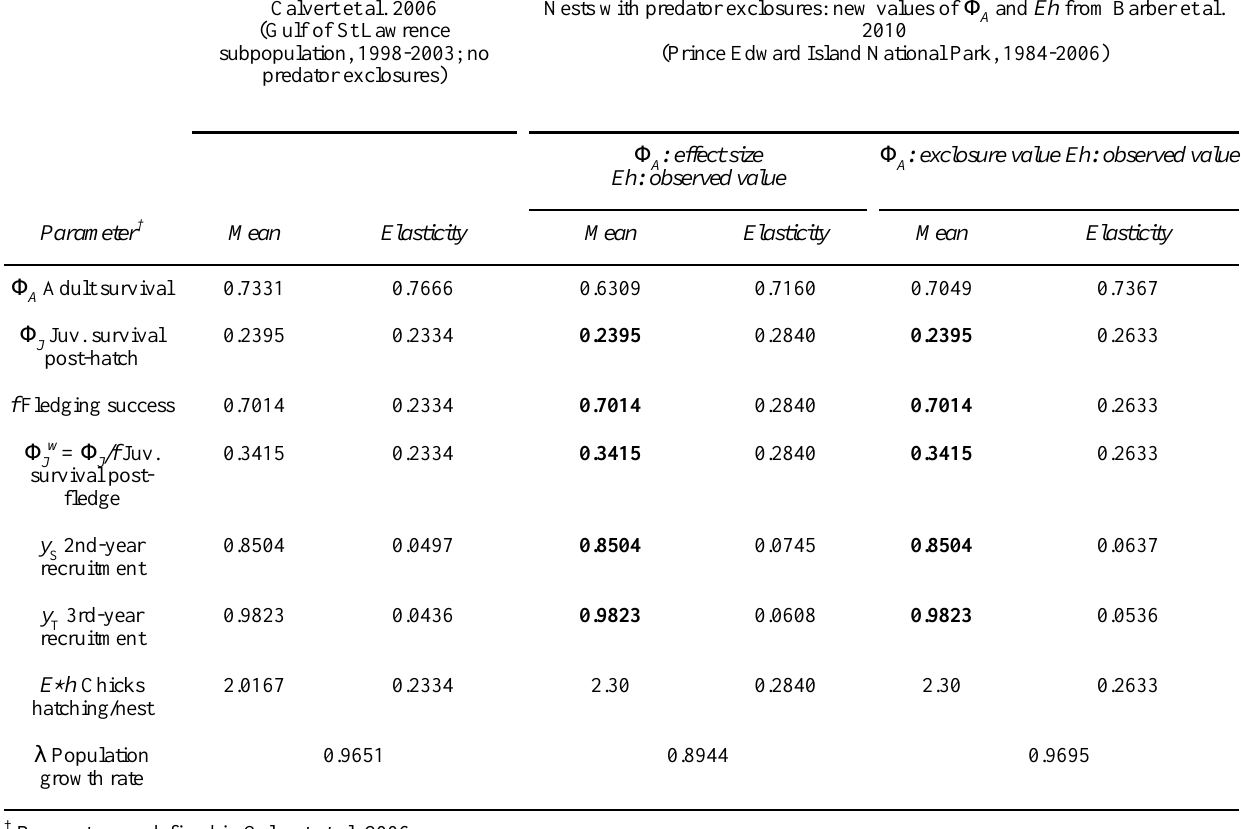
Table 1. Mean parameters estimates, their elasticities, i.e., proportional contributions to growth rate, and estimated deterministic growth rate ( l ) for the eastern Canadian Piping Plover ( Charadrius melodus ), based on the model developed in Calvert et al. (2006). Estimates are shown for the original model parameters estimated from the Gulf of St Lawrence subpopulation (Calvert et al. 2006) vs. estimates for nests with predator exclosures, based on data collected in Prince Edward Island National Park by Barber et al. (2010). Adult survivorship ( F ) estimates for nests with exclosures were calculated both from observed exclosure A vs. nonexclosure differences, i.e., applying the observed effect size to the original value from Calvert et al. (2006), and also directly from the survival value at exclosed nests observed by Barber et al. 2010, whereas only observed values for hatchlings/nest ( Eh ) at exclosed nests were used; see text for details. Estimates shown in bold are taken from Calvert et al. (2006), under the assumption the parameters not measured by Barber et al. (2010) have not changed since the previous study (see